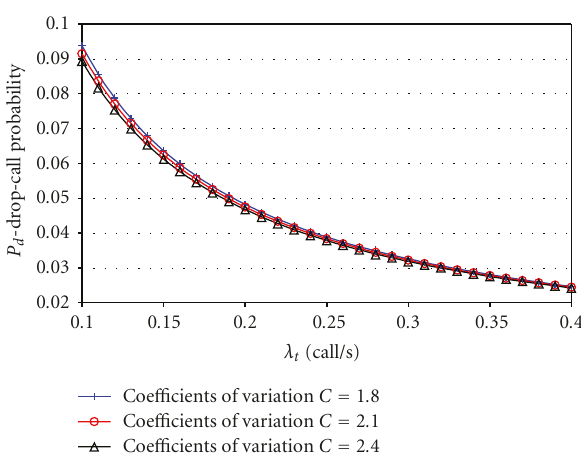
Figure 11: Drop-call probability versus tra ffi c λ t with several mean conversation durations.